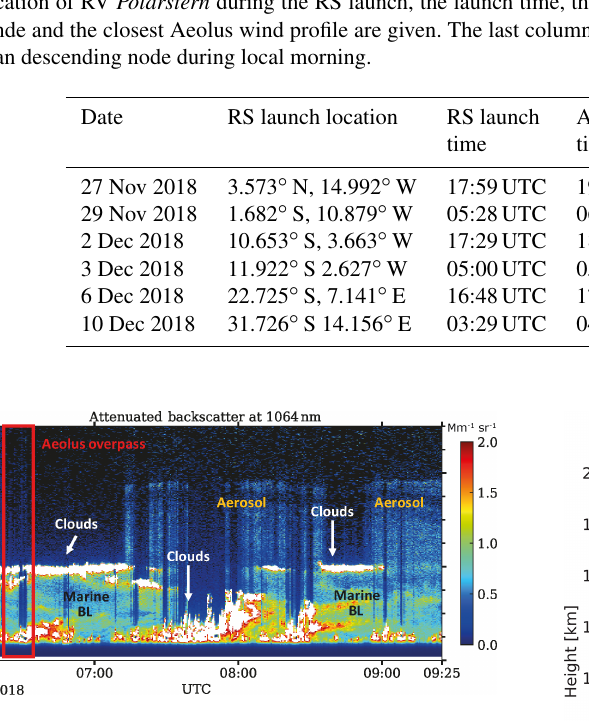
Figure 2. Time–height plot of the attenuated backscatter coefficient at 1064nm of the Raman polarization lidar Polly XT on board RV Polarstern around the time of the Aeolus overpass (red rectangle) on 29 November 2018.